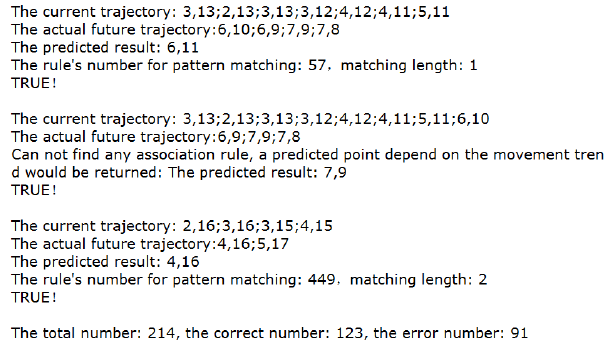
Fig. 6. Predicted results (Console